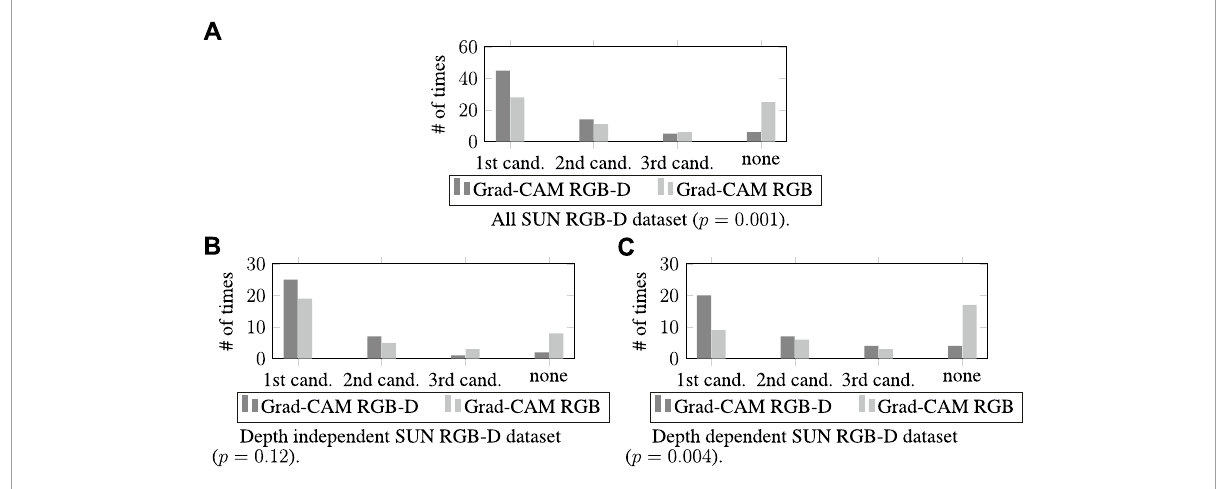
FIGURE 9 The number of times that the generated candidate bounding boxes matched with the target objects for the all SUN RGB-D dataset (in (A) ), depth independent (in (B) ), and dependent (in (C) ) categories.